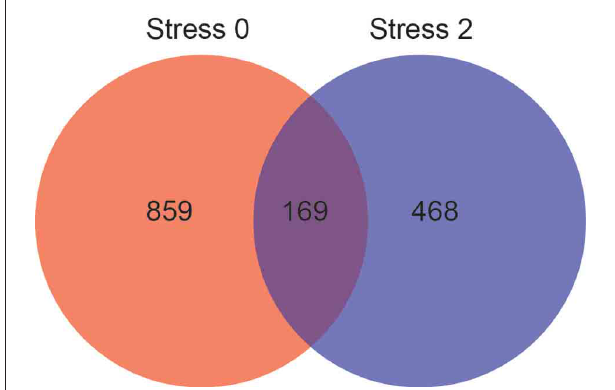
FIGURE 3 | Effect of physical activity status on stress-induced differential gene expression in the DRN by p < 0 . 05. Number of genes differentially expressed immediately following (red) and 2 hours post (blue) stress, and genes differentially expressed at both time points (purple).